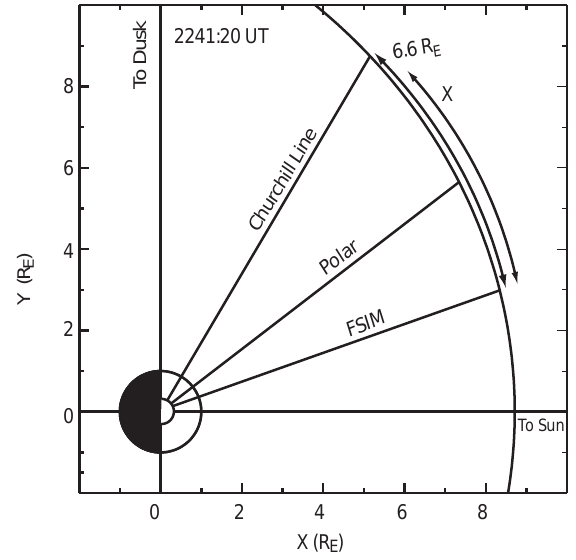
Fig. 16. Schematic showing the longitudinal extent of the reconnec- tion X -line where the flux transfer event occurred. At the time of the flux transfer event at 22:41:20 UT, magnetic field lines from the equatorial magnetopause to the ionospheric footprints are drawn at three local times corresponding to FSIM, Polar footprint, and the Churchill line, using a simple dipolar magnetic field line. The lon- gitudinal distance at the equatorial magnetopause from FSIM to the Churchill line is estimated to be ∼ 6.6R E